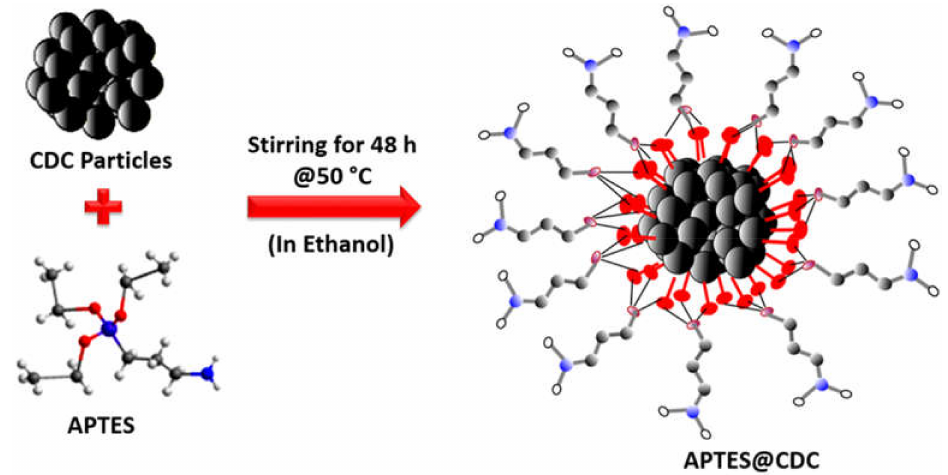
Figure 1. Schematic representation of the surface modification of the CDC using